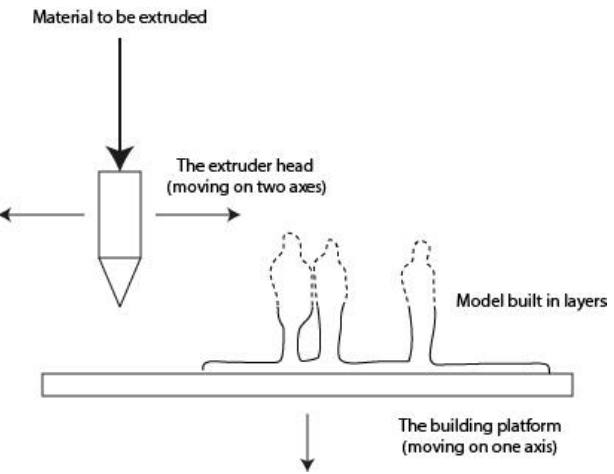
Figure 1. The operating principle of Fused Deposition